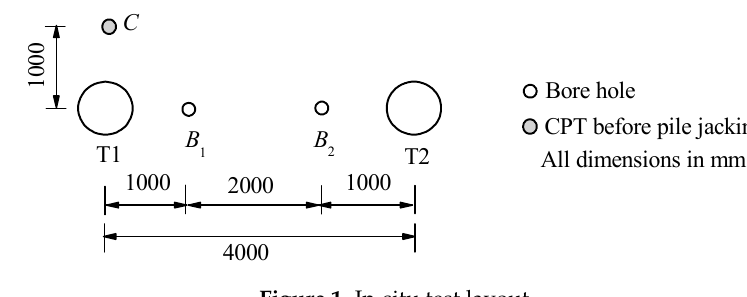
Figure 1. In-situ test layout.